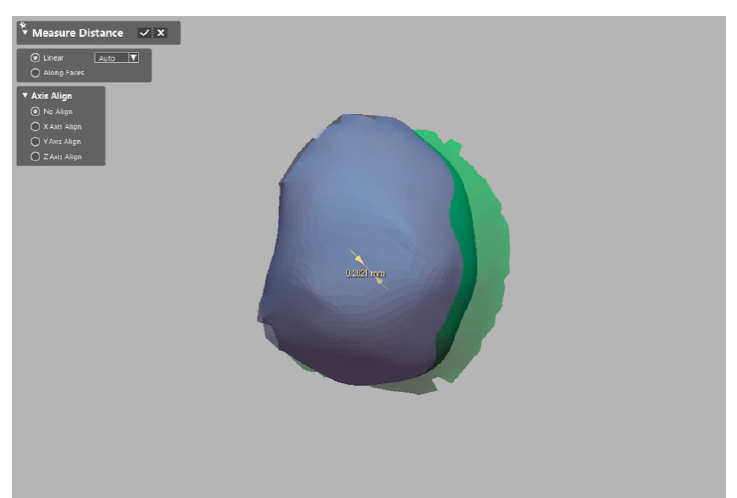
Figure 5. Measurement of 3D linear deviation between the 3D reconstruction and the registered optical scan images using the center point of fiducial marker.